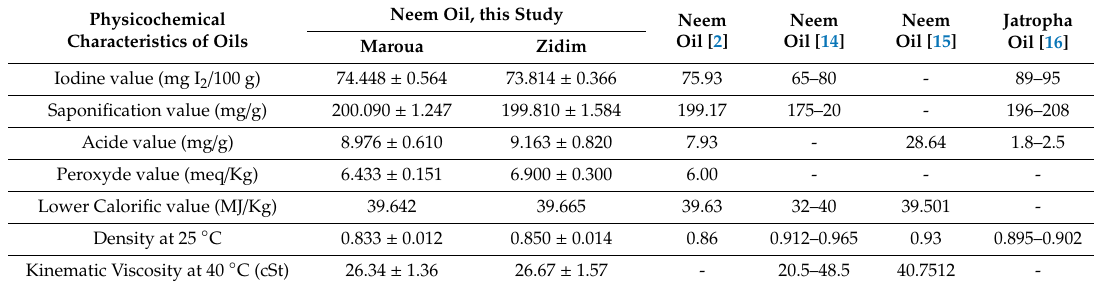
Table 3. Physicochemical characteristics of the neem oils studied compared to those of other